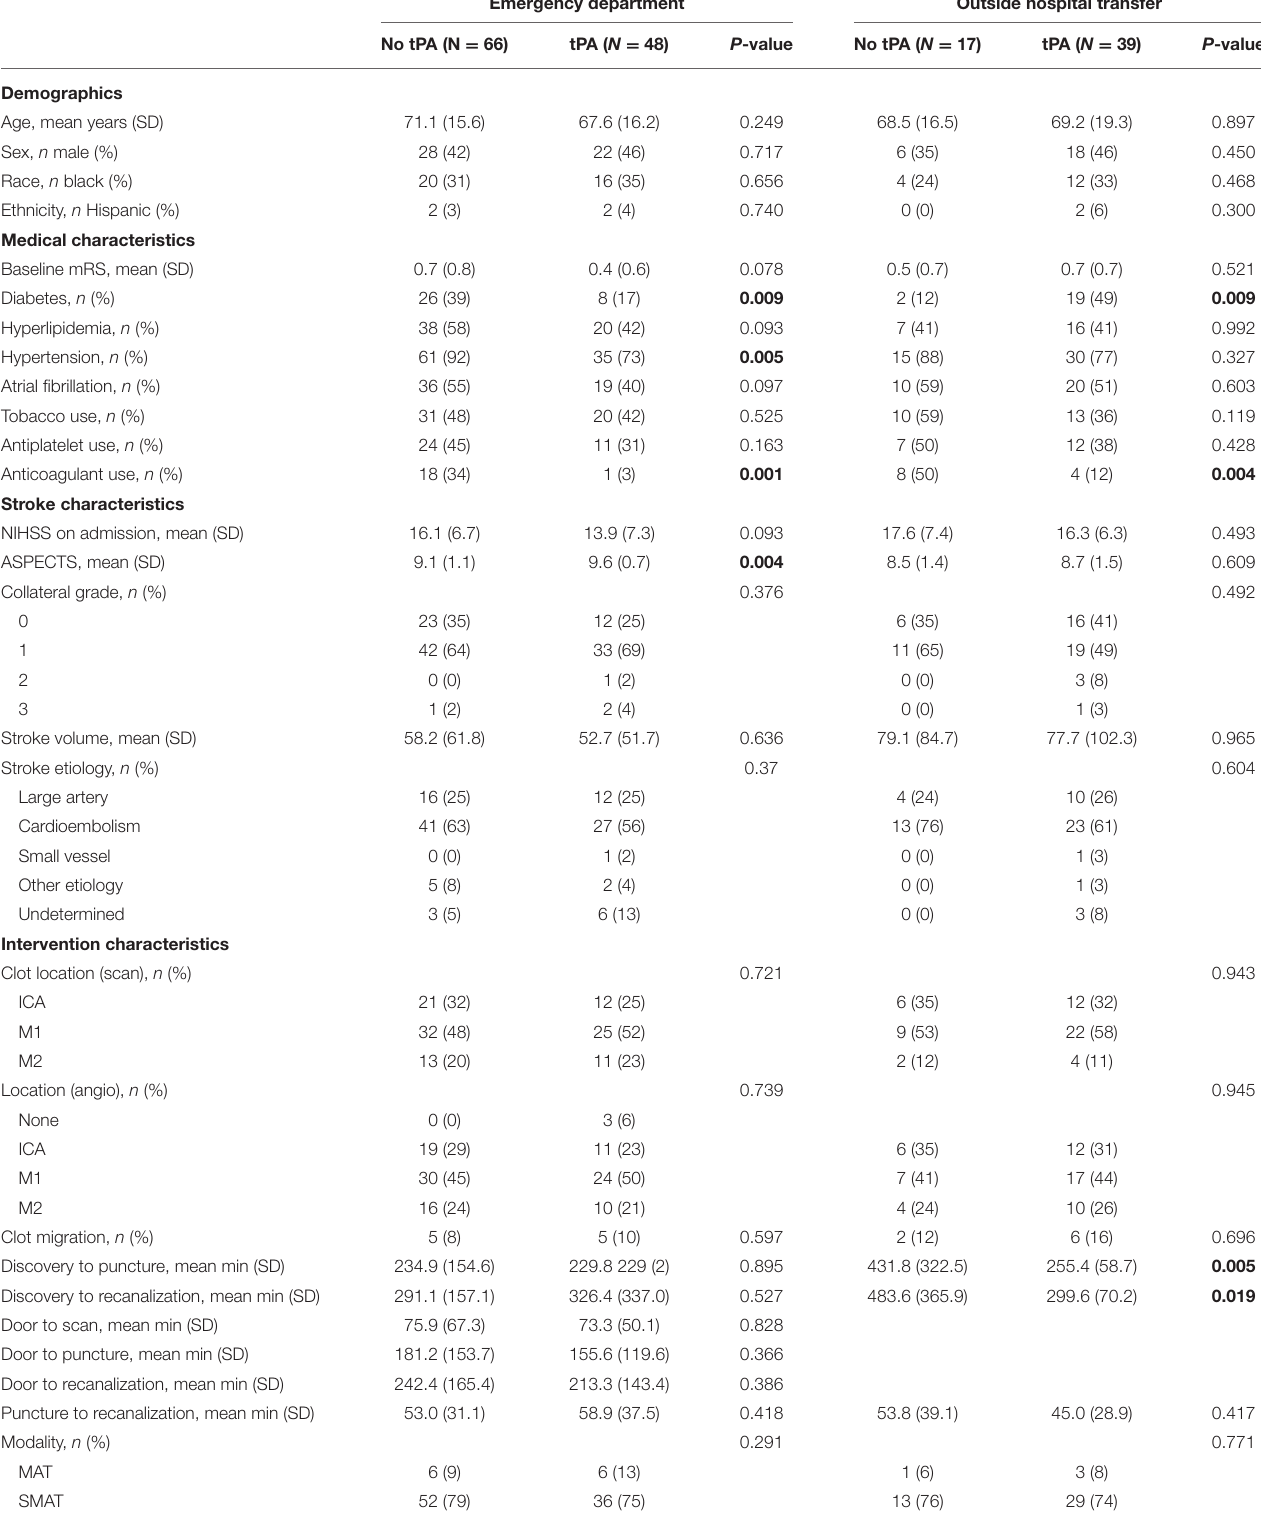
TABLE 2 | Effect of IV